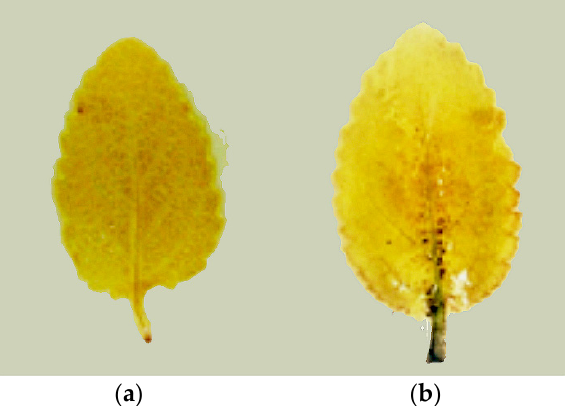
Figure 4. Histochemically detected hydrogen peroxide (H 2 O 2 ) in the leaves of Salvia sclarea forming brown precipitates with 3,3’-diaminobenzidine (DAB) under ( a ) 5 µM (control) or ( b ) 900 µM (excess) Zn levels.